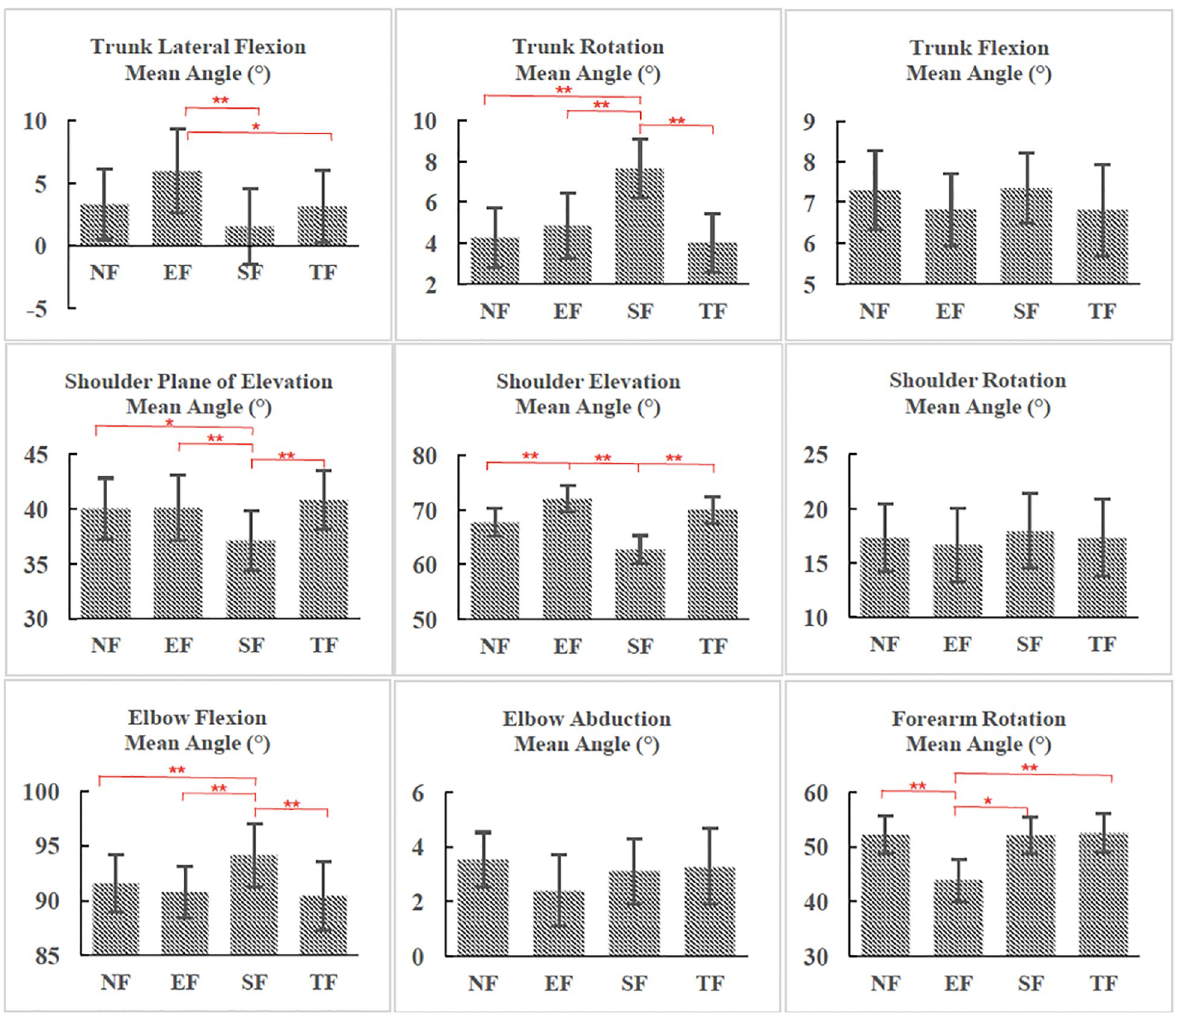
Fig 3. Joint angles between conditions (NF vs EF vs SF vs TF). � NF, EF, SF and TF represent non-fatigued RPT, elbow fatigued RPT, shoulder fatigued RPT and trunk fatigued RPT respectively. Angle definitions refer to the definitions by Gates et al. (2016) and We et al. (2005). The signs of trunk lateral flexion, trunk rotation, shoulder elevation, shoulder rotation and elbow abduction angles are changed to obtain the positive values. Positive values in trunk lateral flexion, trunk rotation and trunk flexion angle means bending towards the non-reaching side, rotating towards the reaching side and bending forward respectively; Positive shoulder elevation angle and shoulder rotation angle stands for humerus horizontal flexion forward, humerus elevation, humerus external rotation. Positive elbow flexion, elbow abduction and forearm rotation means forearm flexion, forearm abduction and pronation. � indicates p < 0.05, �� indicates p <